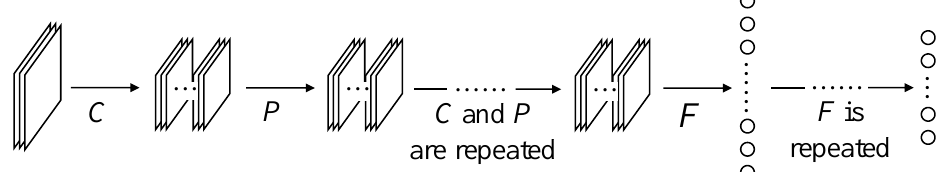
Figure 1. Basic structure of convolutional neural network (CNN) ( C = convolutional layer, P = pooling layer, and F = fully connected layer).